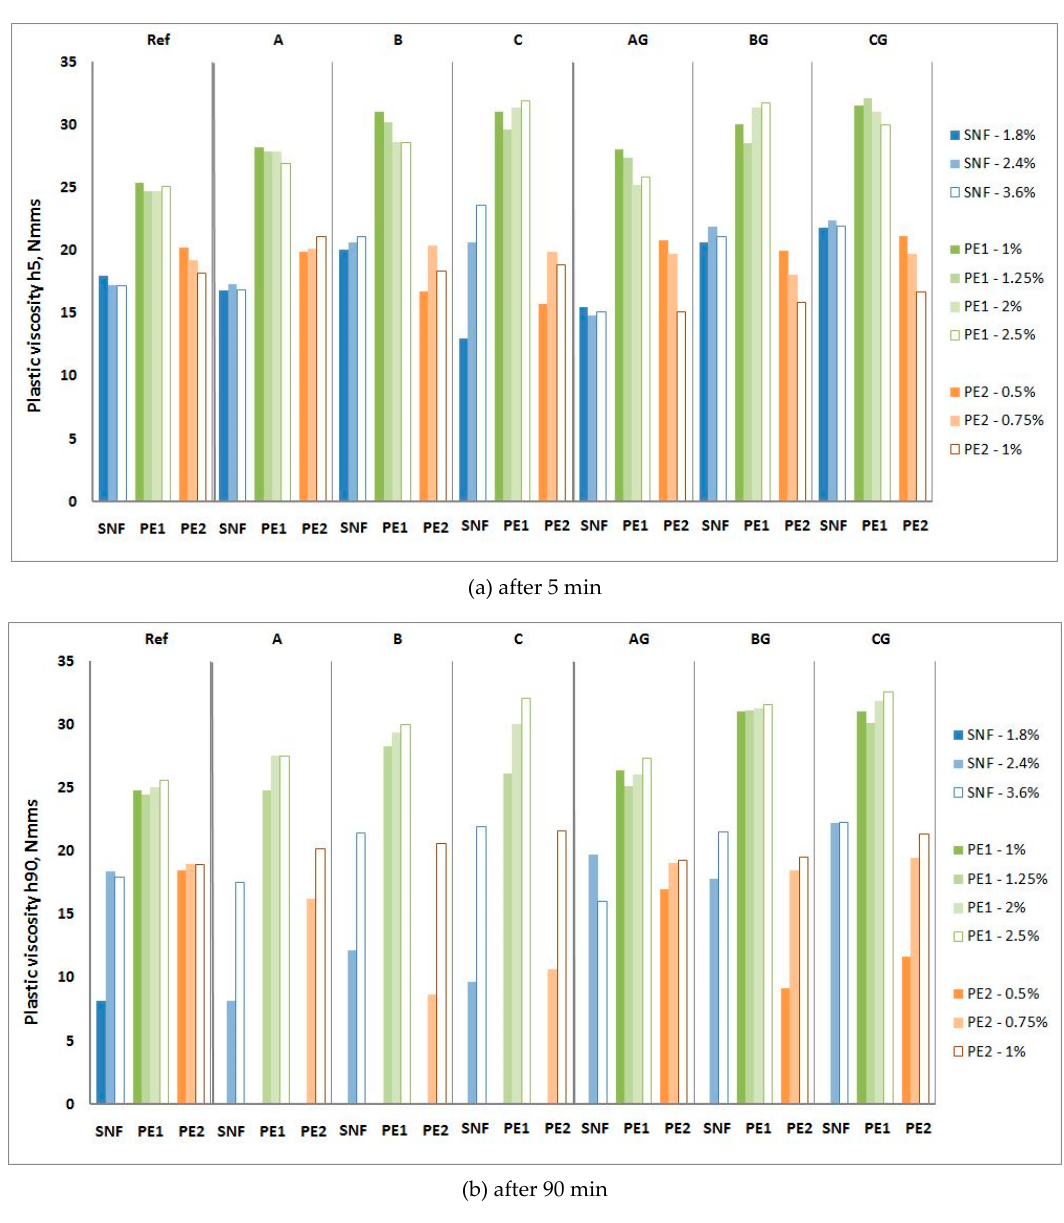
Figure 13. Influence of SNF, PE1 and PE2 on plastic viscosity h of mortars with raw and ground CFA. ( a ) after 5 min; ( b ) after 90 min. Table 7. Influence of P and SP on air content in mortars with and without